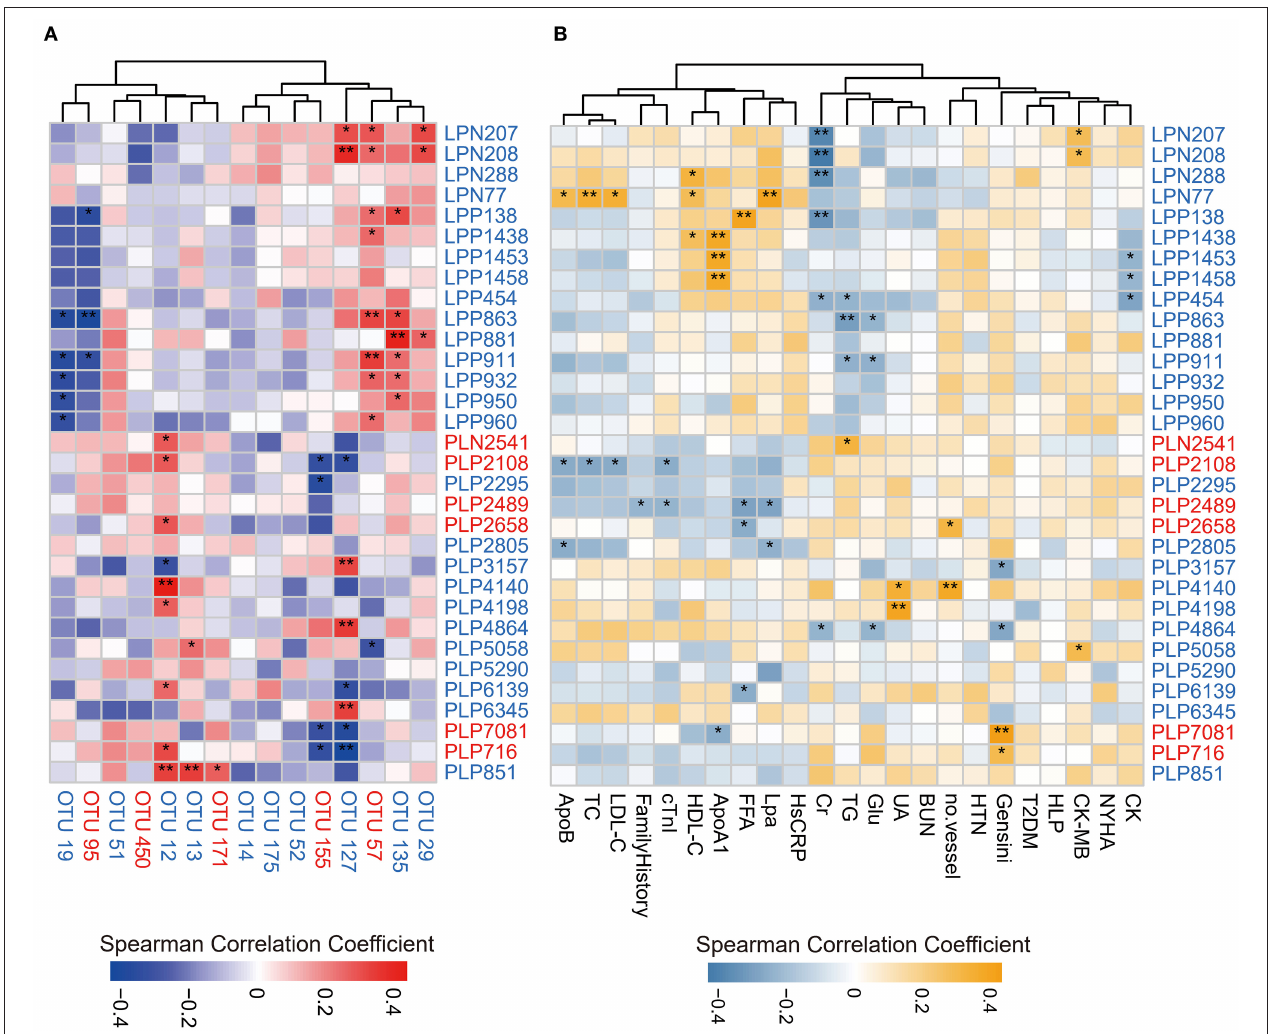
FIGURE 5 | Spearman correlations between differential serum metabolites and OTUs associated with moderate alcohol consumption or major clinical parameters for CAD. (A) Spearman correlations between differential serum metabolites and OTUs associated with moderate alcohol consumption. (B) Spearman correlations between differential serum metabolites and major clinical parameters associated with moderate alcohol consumption. The IDs of metabolites or OTUs are highlighted in red (enriched in MD-CAD) and blue (depleted in MD-CAD). * P < 0.05, ** P < 0.01. ApoB, apolipoprotein B; TC, total cholesterol; LDL-C, low-density lipoprotein cholesterol; family history: having a family history of CAD; cTnI, cardiac tropinin I; HDL-C, high-density lipoprotein cholesterol; ApoA1, apolipoprotein A1; FFA, free fatty acid; Lpa, lipoprotein (a); HsCRP, high-sensitivity C-reactive protein; Cr, creatine; TG, triglyceride; Glu, fasting blood glucose; UA, uric acid; BUN, blood urea nitrogen; no. vessel, number of stenosed vessels; HTN, hypertension; T2DM, type 2 diabetes mellitus; HLP, hyperlipidemia; CK-MB, creatine kinase-MB; CK, creatine kinase; NYHA, grade of NYHA